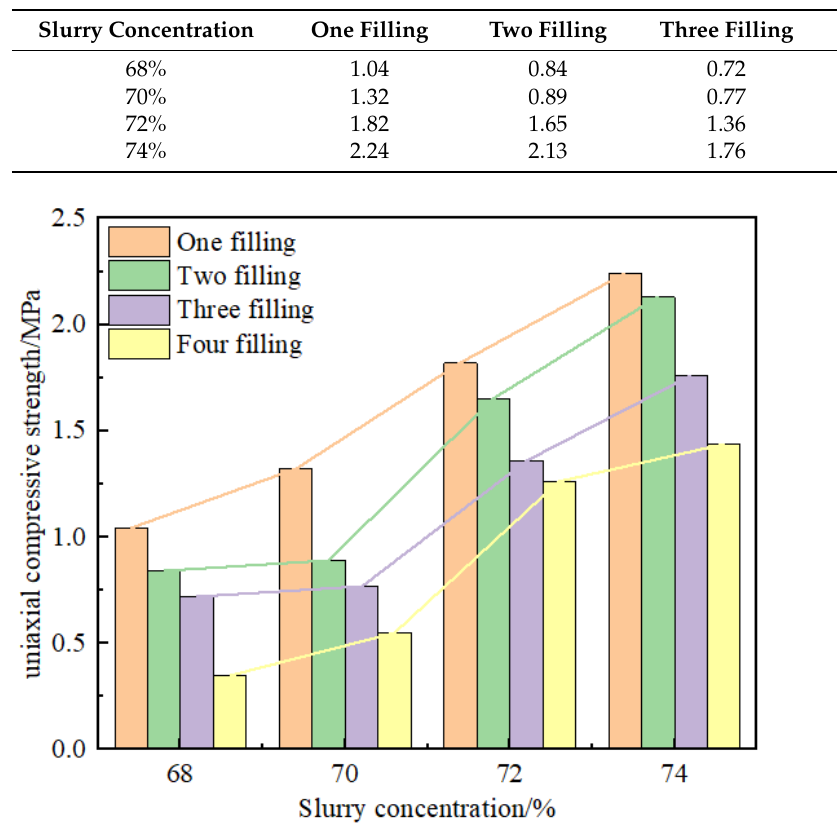
Figure 4. Histogram of compressive strength. Table 3. Two-factor analysis of variance table.